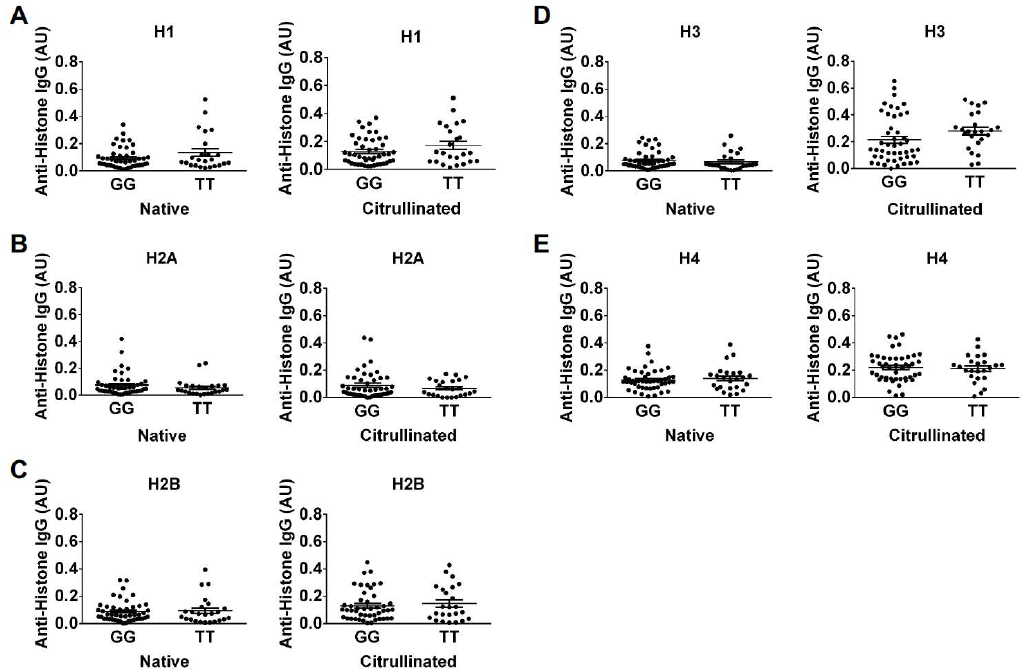
Figure 4. Anti-histone IgG levels in CCP + rheumatoid arthritis do not significantly correlate with genotypes at rs2240335. IgG levels against native and citrullinated histone H1 ( A ), histone H2A ( B ), histone H2B ( C ), histone H3 ( D ) and histone H4 ( E ) measured by ELISA in CCP + rheumatoid arthritis subjects homozygous for the G or T allele at rs2240335 were compared by t-test. For all panels, graphs depict average absorbance values in arbitrary units (AU) ± SEM, no comparisons were significant, and n = 46 GG and 24 TT.